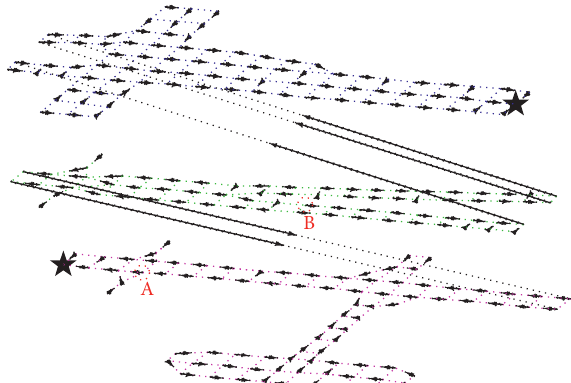
Figure 1: The initial directions given by the CPNSP algorithm before a fire breaks out. CPNSP, CPN based algorithms with distance